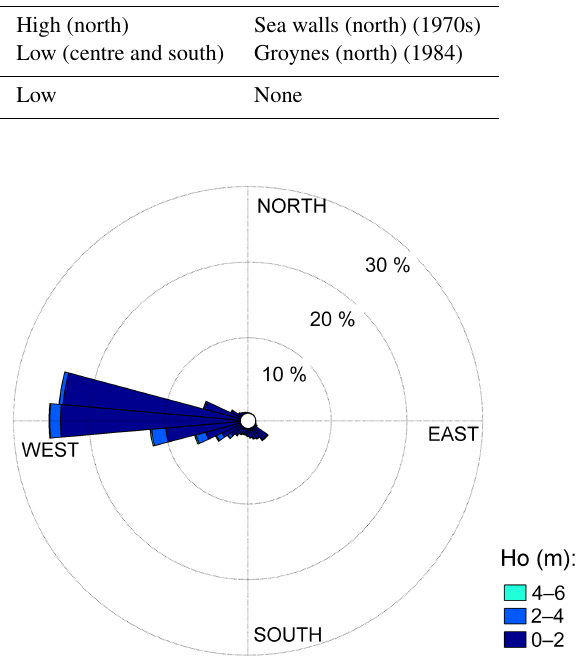
Figure 2. Wave height record during 1956–2010 from Cádiz